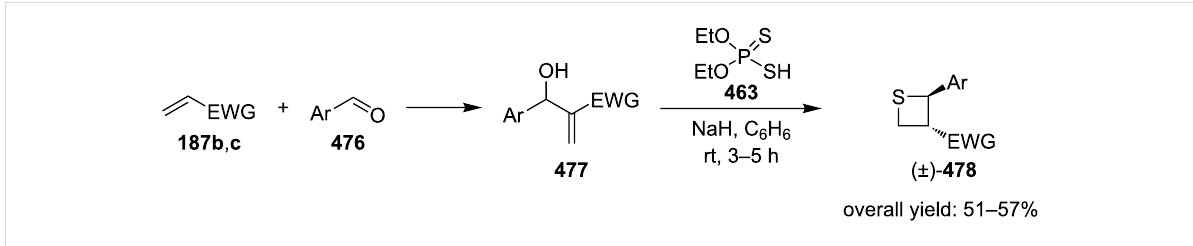
Scheme 109: Phosphorodithioate-mediated synthesis of 1,2-disubstituted thietanes from aldehydes 476 and acrylonitrile ( 187b ) and methyl acrylate ( 187c